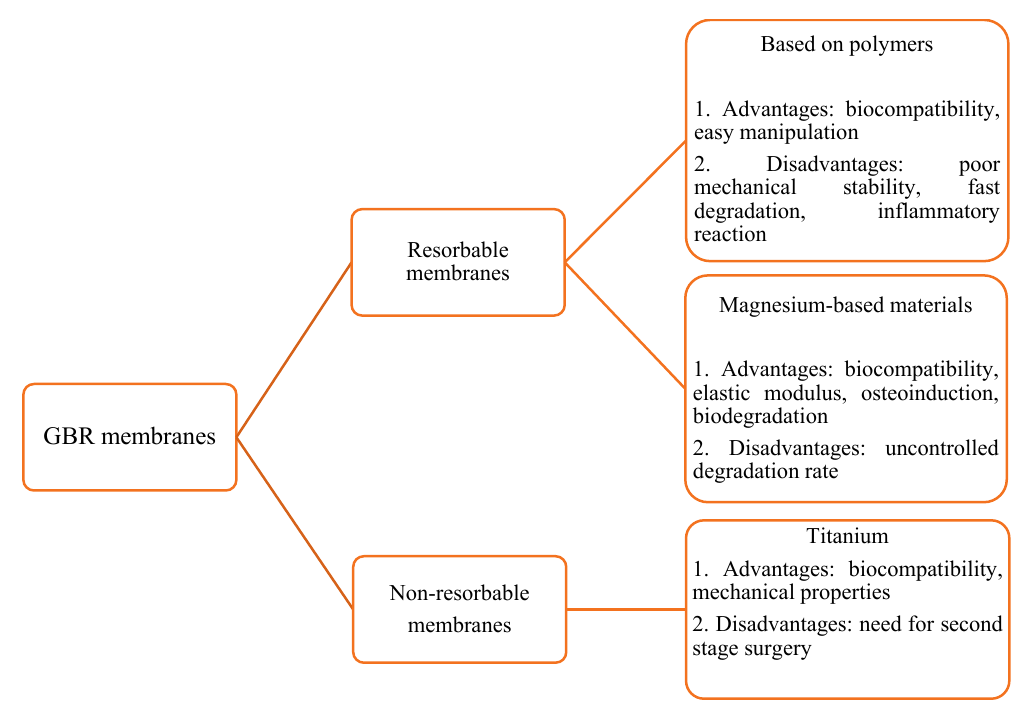
Figure 1. Guided bone regeneration membranes (GBR) for bone tissue regeneration .